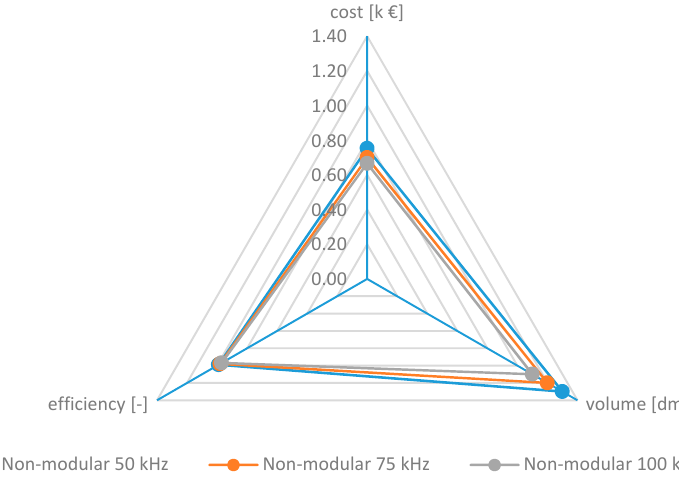
Figure 7. Comparison of qualitative parameters for a non-modular concept in dependency on switching frequency.